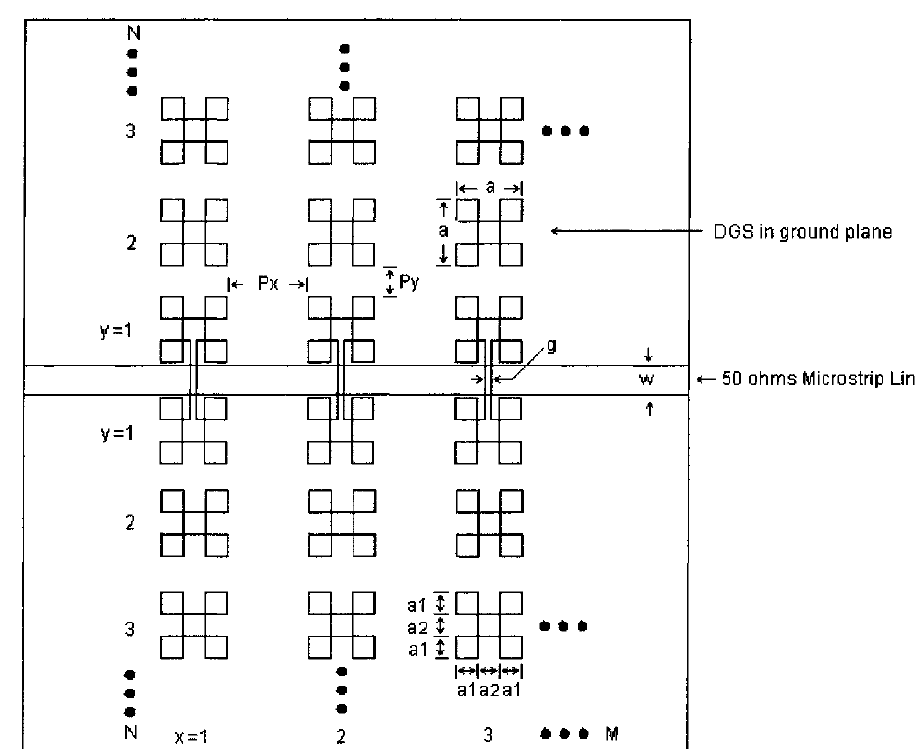
FIGURE 3 Microstrip line with DGA on the ground